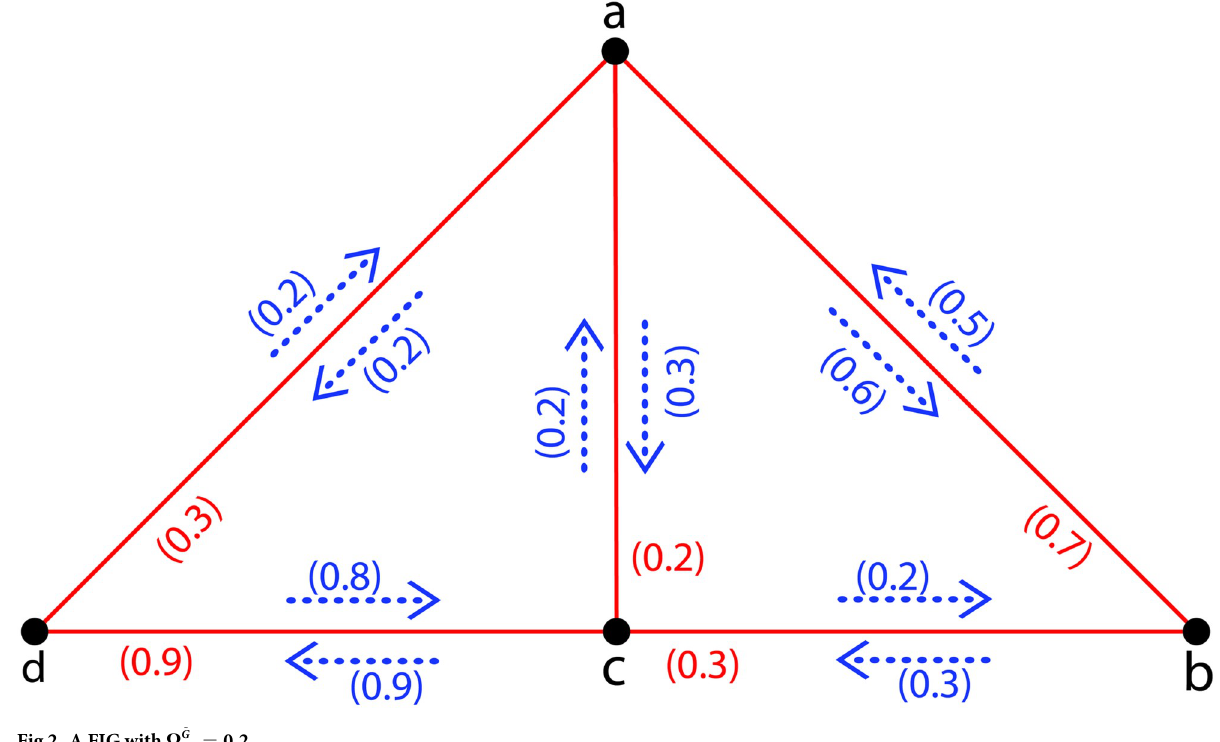
Fig 2. A FIG with Ω ~ G